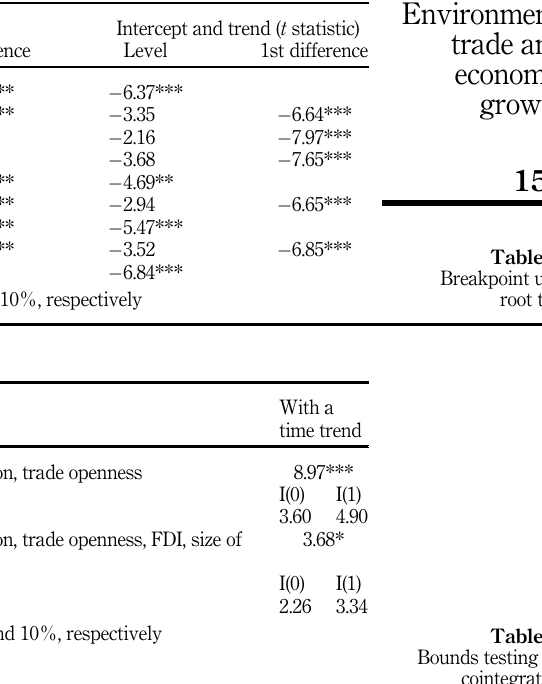
Table 2. Bounds testing for